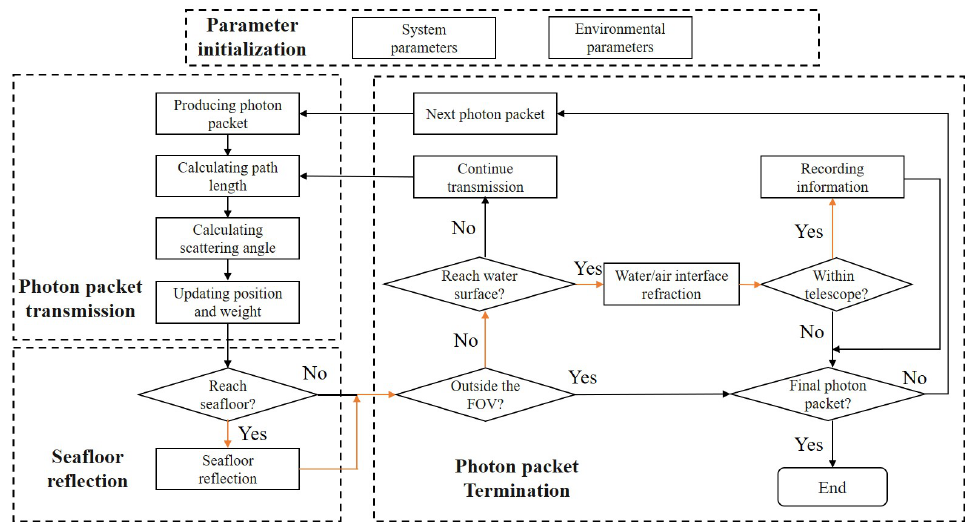
Figure 2. Flow chart of semi-analytic Monte Carlo simulation for water forward scattering in lidar bathymetry.